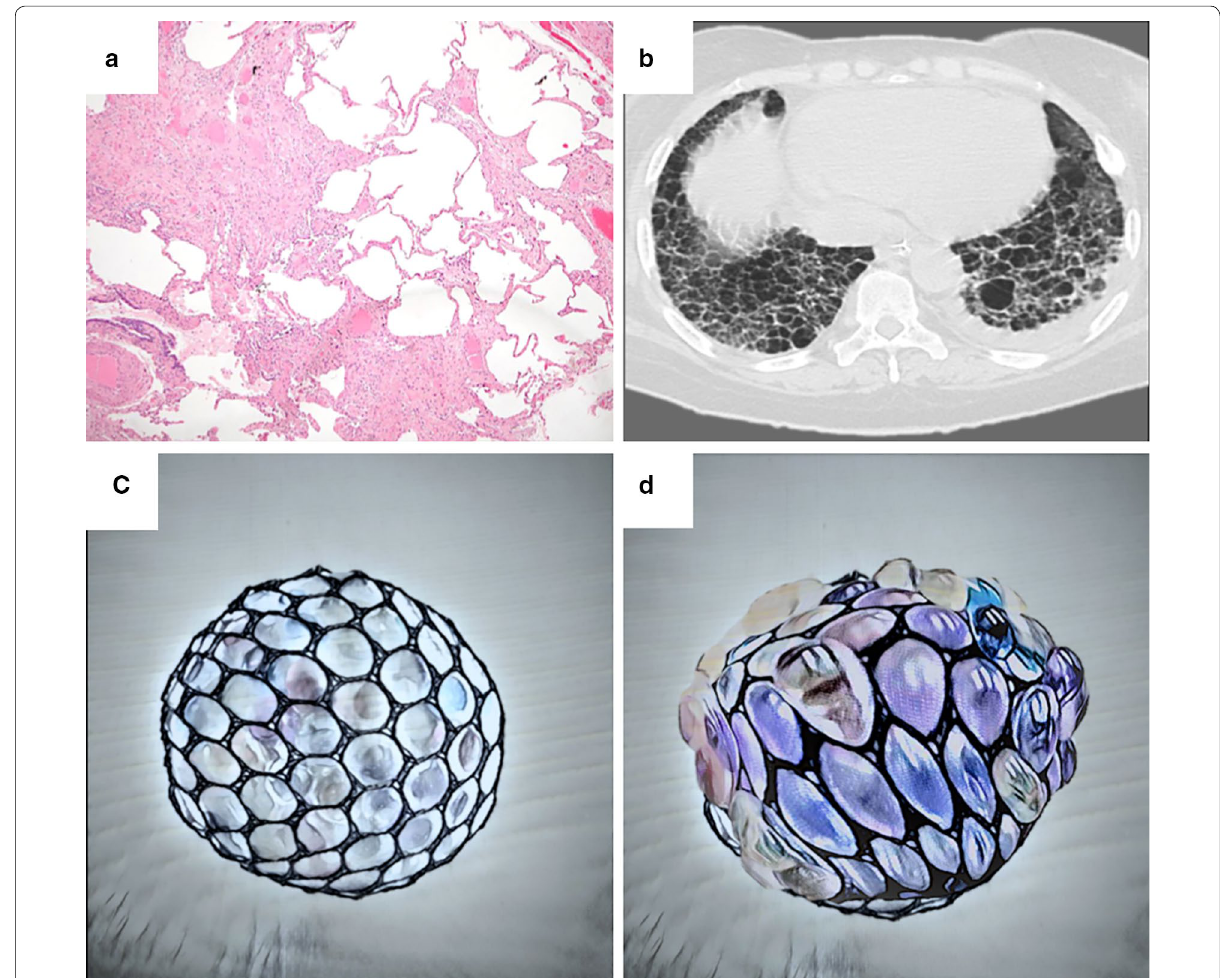
Fig. 2 a Histological evidence of spatial heterogeneity with relatively spared alveolar spaces surrounded by patchy areas of fibrosis with multiple fibroblastic foci in a patient with IPF. b CT appearance of UIP pattern in a patient with IPF. c Graphical appearance of a “squishy ball” depicting the elastic features of fibrotic lung in resting position. d Squishy ball subjected to the application of an internal pressure: the increase of the pressure inside the object causes throttling of the elastic part of the body through the inelastic net that wraps the ball determining a mechanical disadvantage during the